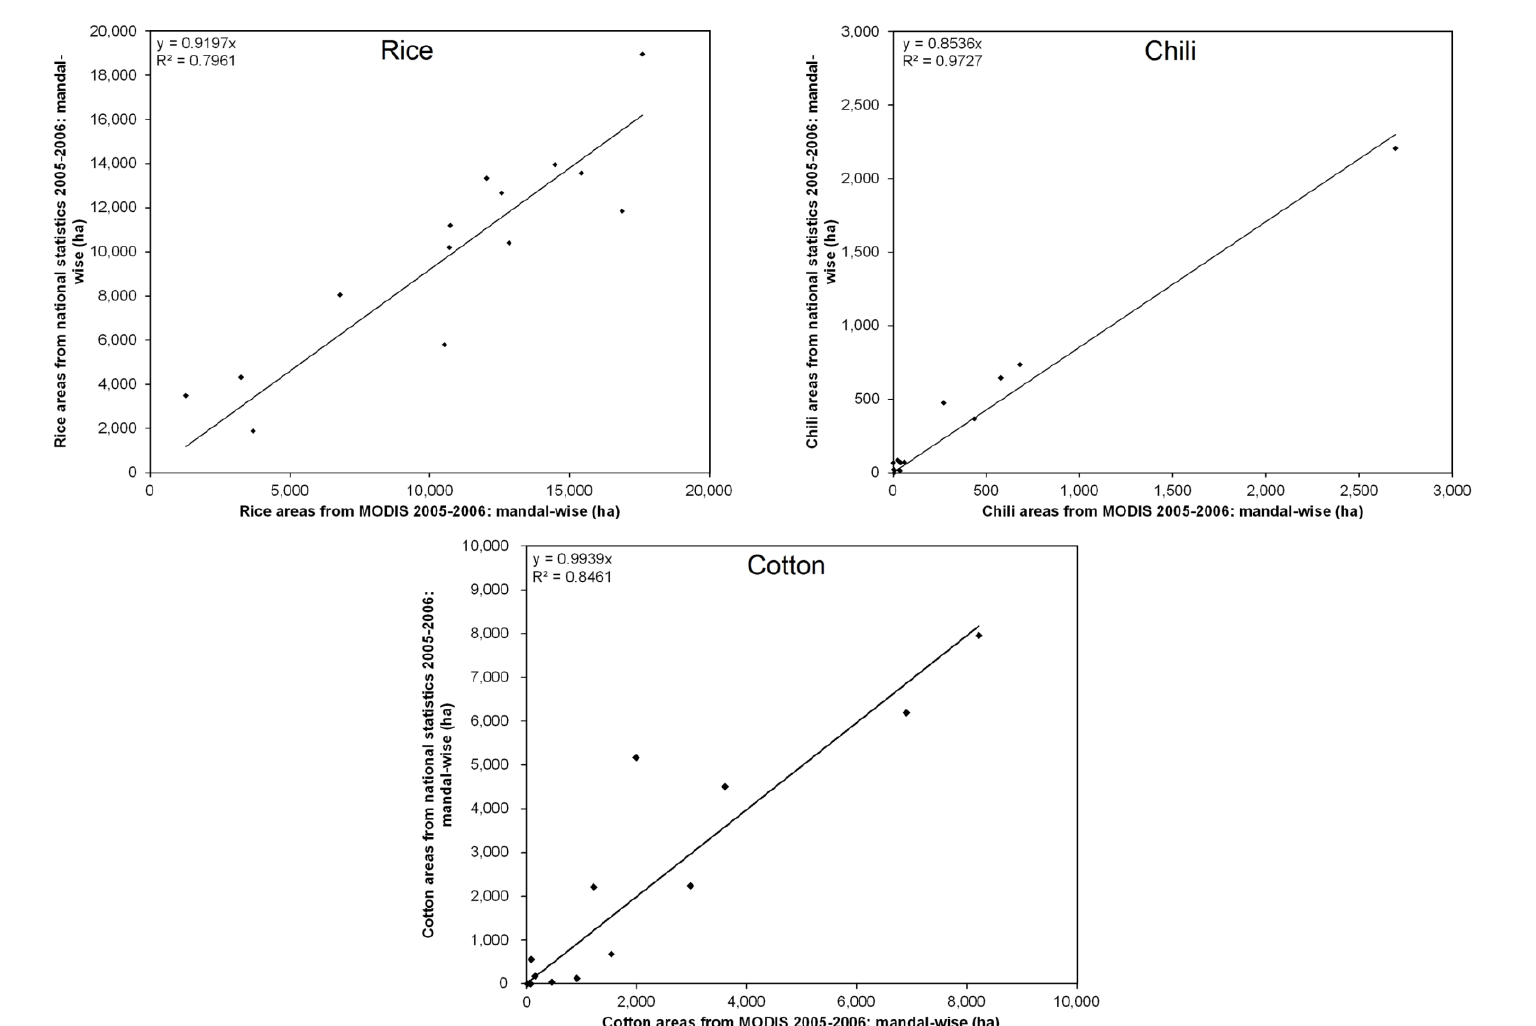
Figure 5. Scatter plot showing correlations between MODIS-derived areas and NAS in the Nalgonda zone of the Nagarjuna Sagar (NJS) command area during the years